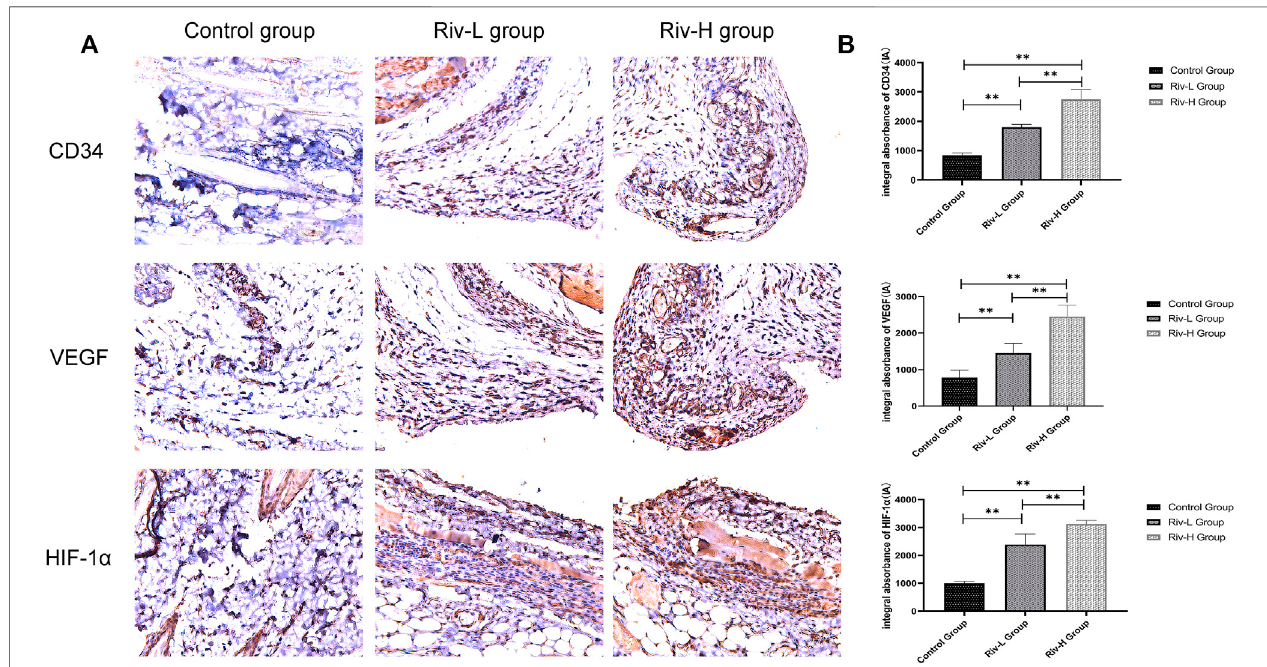
FIGURE 8 | (A) CD34, VEGF and HIF-1 α expression were measured in the skin fl aps of the three groups by immunohistochemical analysis. (B) CD34, VEGF and HIF-1 α expression levels in the three groups. Rivastigmine treatment increased the expression of CD34, VEGF and HIF-1 α . ** p <